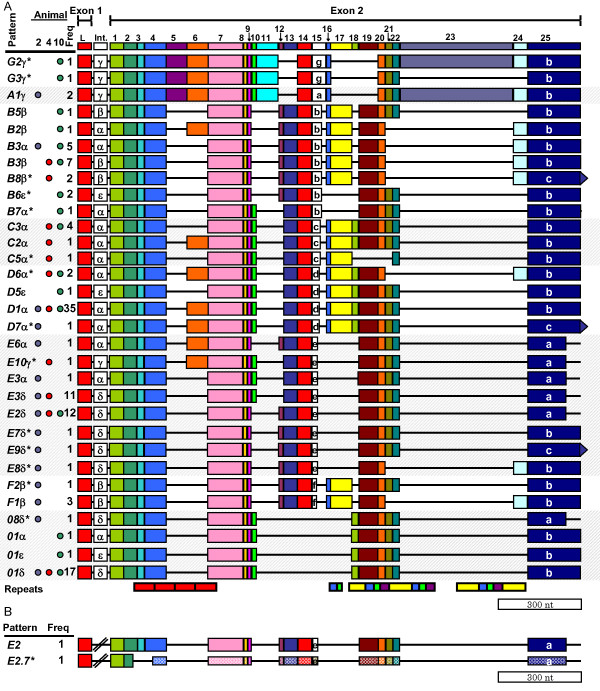
cDNA-based Element patterns of the 185/333 genes. A. Exon element patterns. Gene sequences were manually aligned based on alignments of cDNA sequences. The insertion of gaps (black lines), which defined the 25 elements (shown as colored boxes) [30]. A consensus sequence containing all the elements and the locations of the two exons is shown at the top. The source of each gDNA is indicated by the colored dots in the columns labeled "Animal". Blue dots indicate that the pattern was isolated from animal 2, red dots from animal 4, and green dots from animal 10. The frequency with which the patterns were found is indicated in the column labeled "Freq". The element patterns are sorted into groups (grey background shading) based on the subtype of Ex15 (specified by the letter in the box). The locations of the five types of repeats [27,30] are shown at the bottom of A (red boxes indicate type 1 repeats; blue = type 2; green = type 3; yellow = type 4; and purple = type 5). Patterns not previously identified from cDNA analysis [27,30] are denoted with an asterisk (*). The position of the stop codon in element Ex25 is indicated by the letter present in the box and the size/shape of the box (Additional file 2, Additional file 3). There are 31 unique patterns based on both exon elements and intron type. B: Intronless genes with unique element patterns amplified from BAC DNA. Untranslated sequence (due to a missense deletion) is indicated by lighter shading and narrower boxes for E2.7. The locations of the repeats are the same as A.